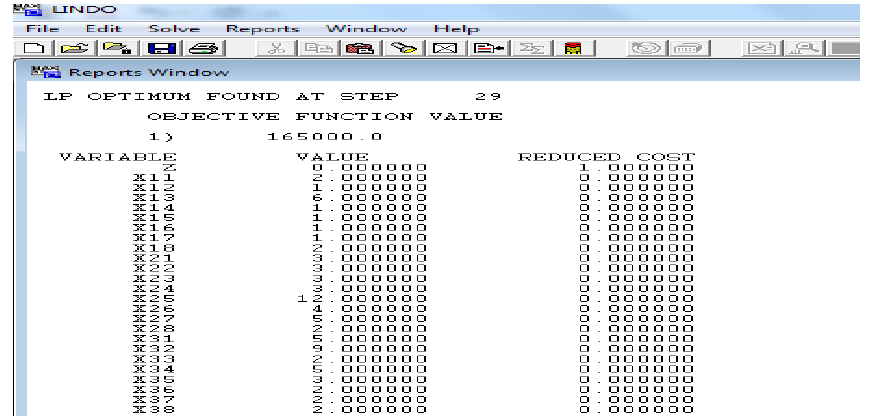
Fig. 1. Output summary of LINDO